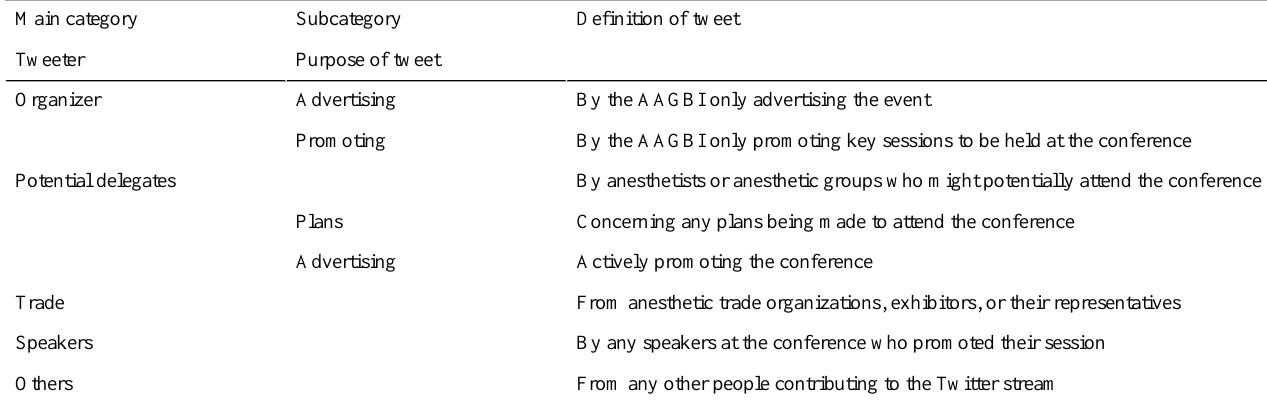
Table 1. Tweets sent before the January 2012 Association of Anaesthetists of Great Britain and Ireland (AAGBI) conference.